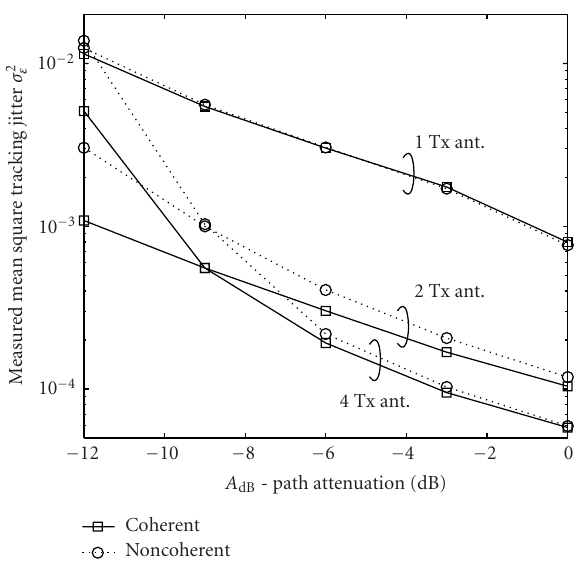
Figure 8: DLL performance-pedestrian (3kph